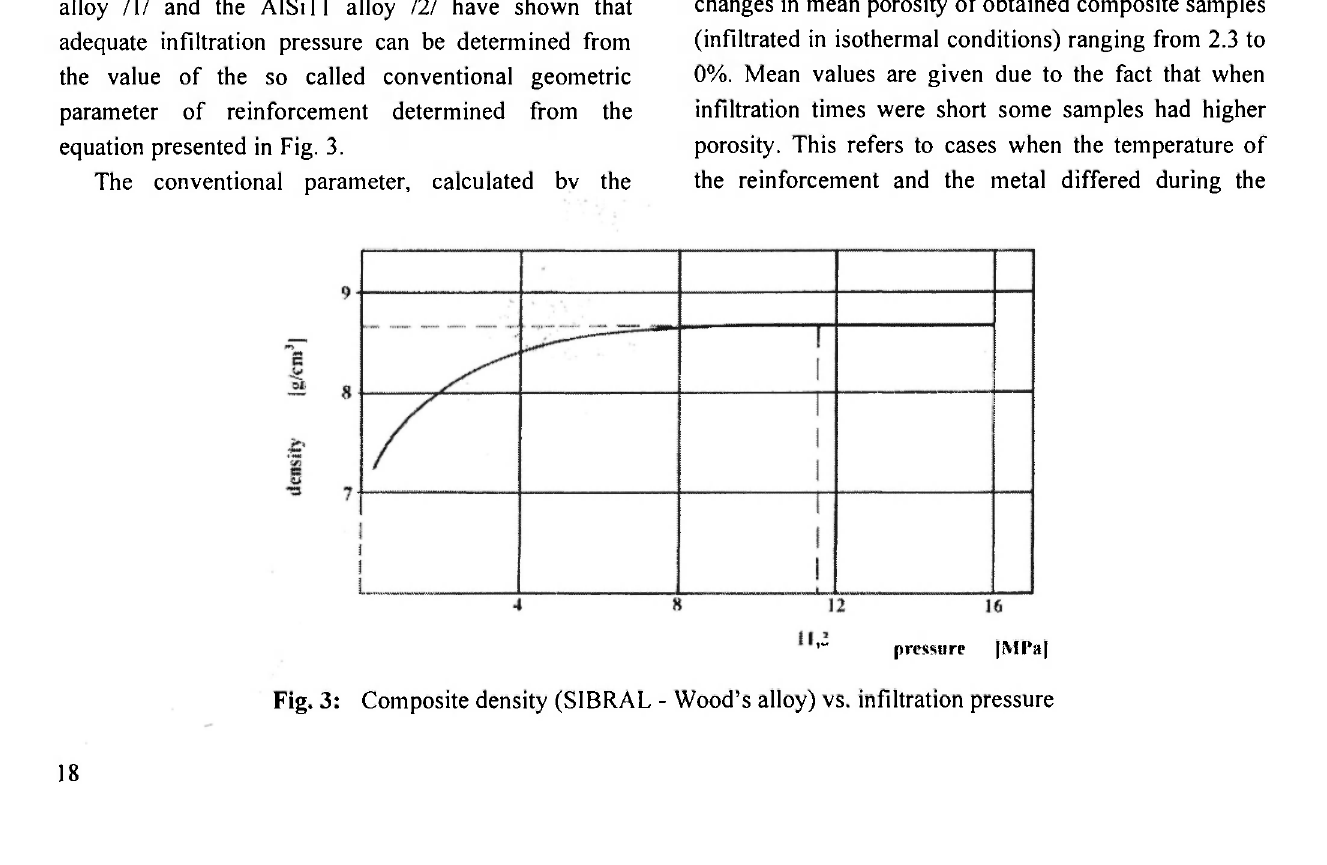
Fig. 3: Composite density (SIBRAL - Wood's alloy) vs. infiltration